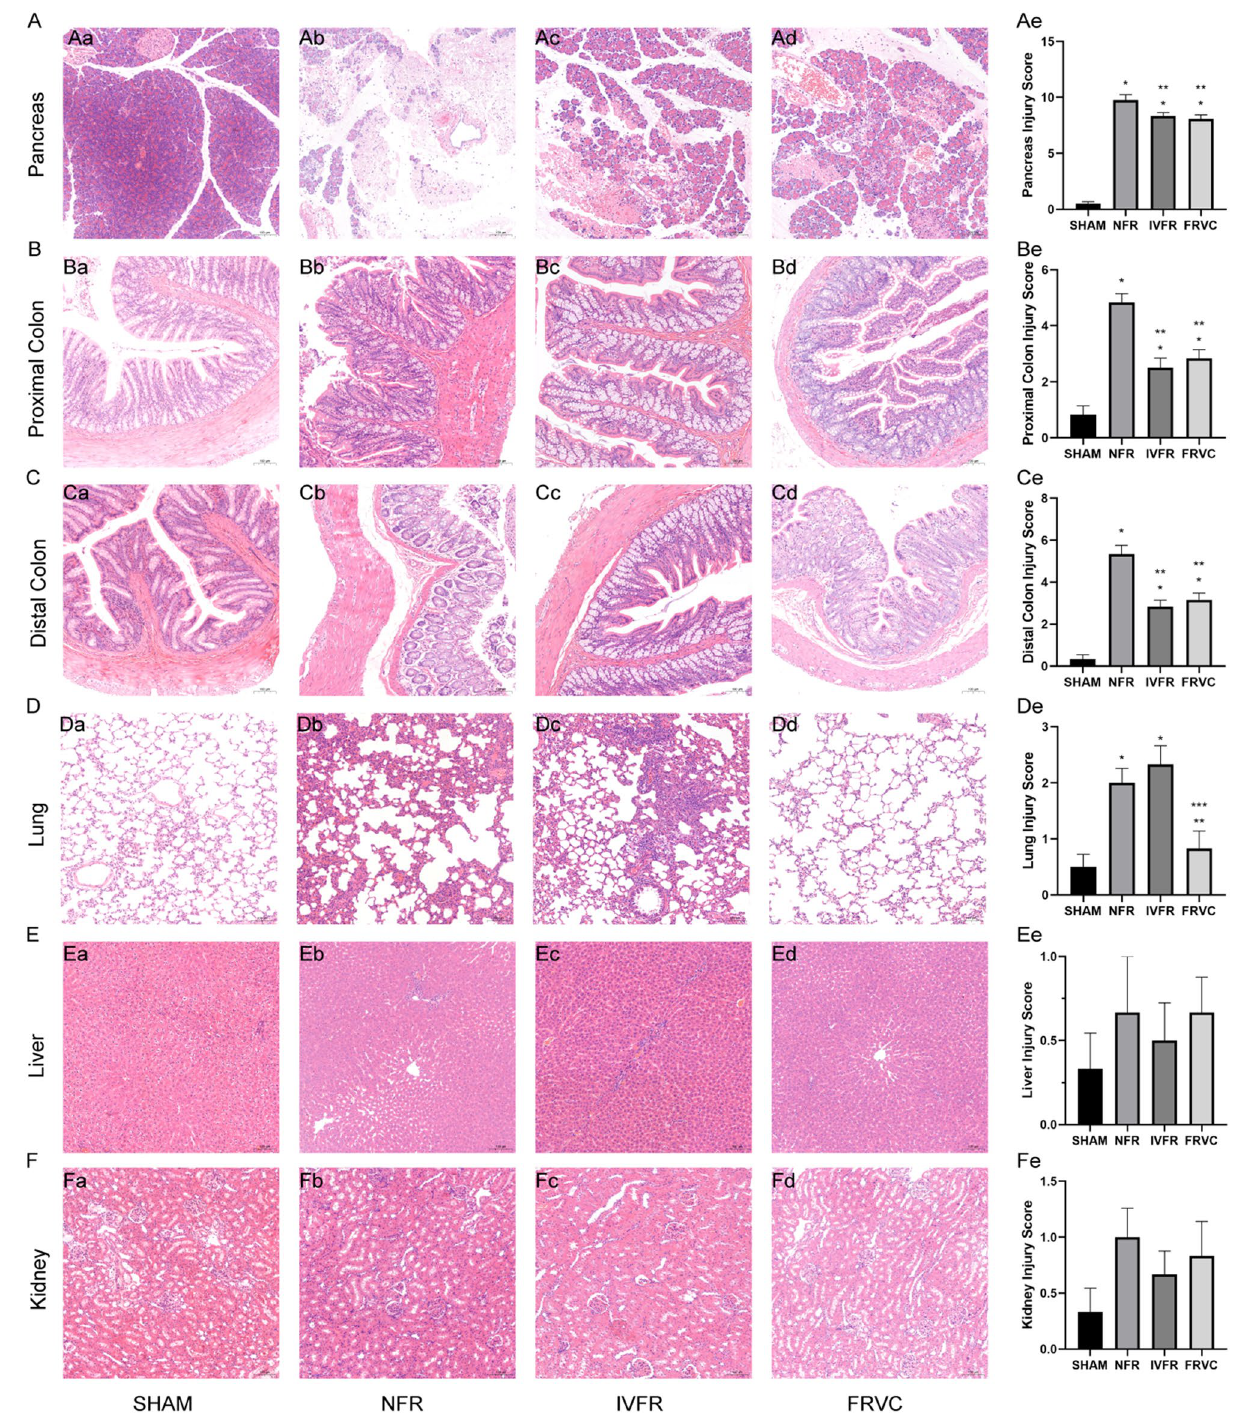
Figure 3. Organ damage of SAP rats and SAP rats treated with IVFR or FRVC. ( A – F ) The severity of pancreas, proximal colon, distal colon, lung, liver, and kidney injury was assessed via H&E staining and histological scores. Magnification: 100×. Scale bar: 100 μm. * p < 0.05 compared to SHAM, ** p < 0.05 compared to NFR; *** p < 0.05 compared to IVFR. SHAM: the rats treated with sham operation and no fluid resuscitation; NFR: the rats treated with the SAP operation and no fluid resuscitation; IVFR: the rats treated with the SAP operation and intravenous normal saline infusion; FRVC: the rats treated with the SAP operation and normal saline infusion via